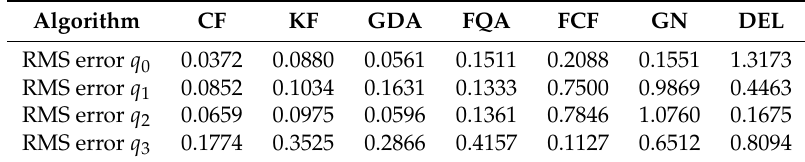
Table 2. RMS errors of random